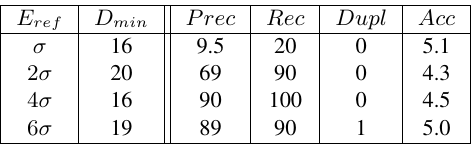
Table 3: Results on synthetic dataset for increasing D